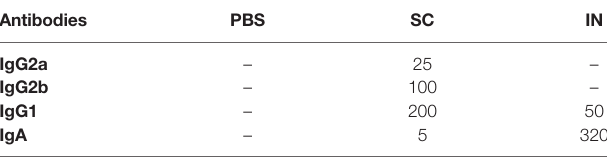
TABLE 2 | Antigen speci fi c mucosal-antibodies endpoint titers of immunized mice.